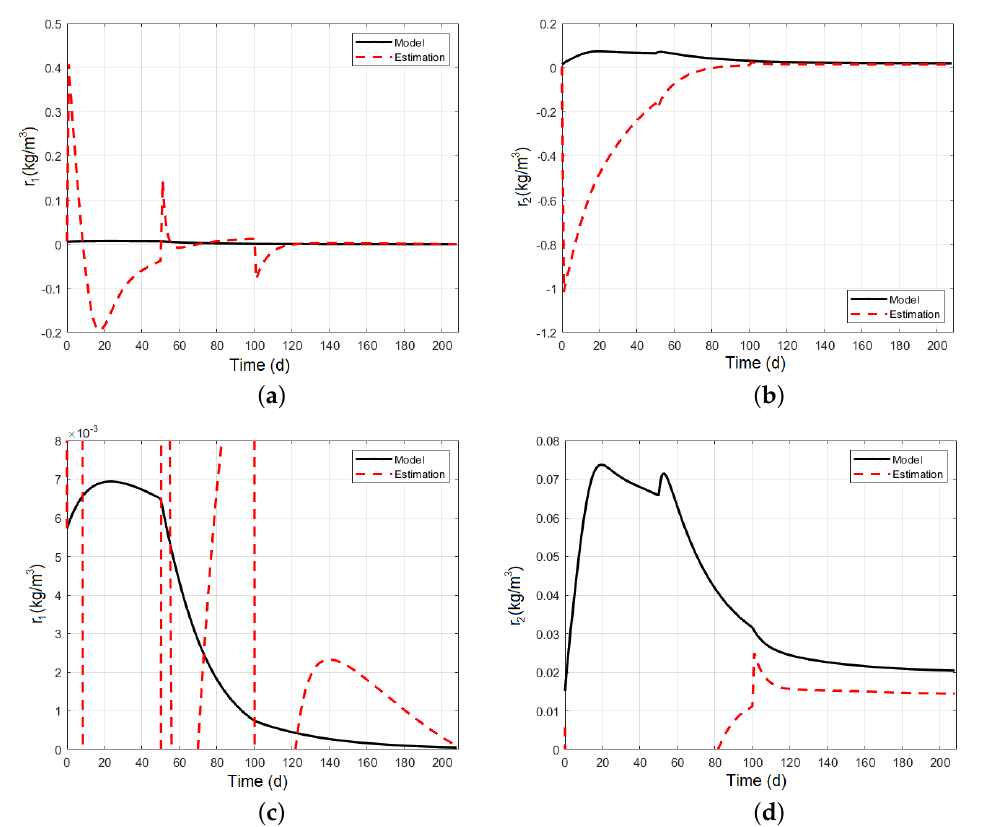
Figure 3. Process of convergence in the estimation of reaction rates. ( a ) Values of r 1 ; ( b ) values of r 2 ; ( c ) zoom in r 1 ; ( d ) zoom in r 2